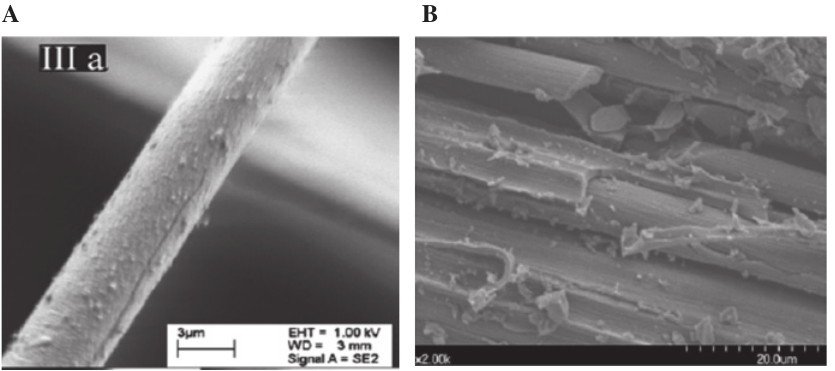
Figure 4: SEM image of basalt fiber after water treatment. (A) BF after water age for 4 weeks [20], (B) BF treated with seawater for 90 days [21].